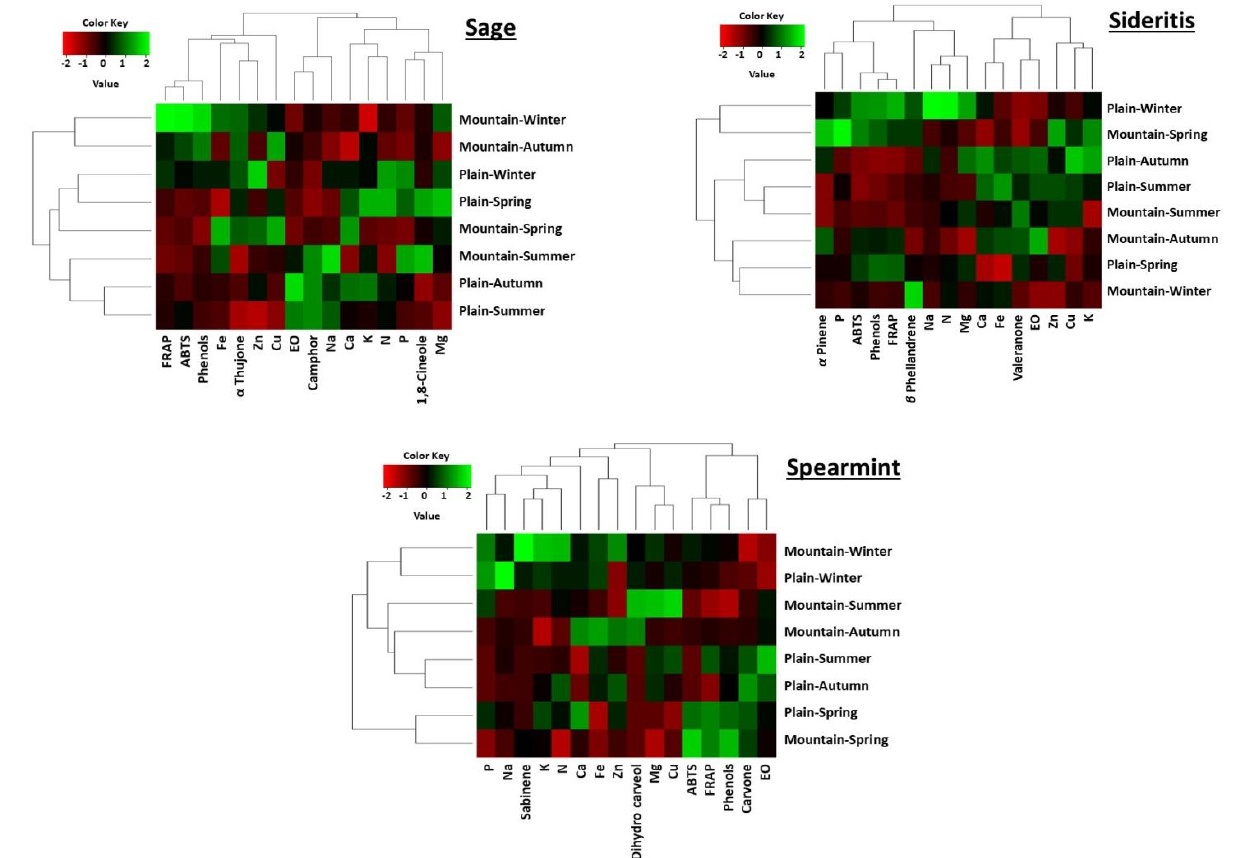
Figure 1. Relative changes (Heat maps) in total phenols (mg GAE g −1 Fw), antioxidant and reducing activity (FRAP, ABTS, mg trolox g −1 Fw), macronutrient (g kg −1 ) and micronutrient content (mg kg −1 ) content, and essential oil (EO) yield (%) and three major EO components in sage, sideritis and spearmint as affected by the altitude (mountain vs. plain) and season (summer, autumn, winter, spring). Red shades indicate the lower level (less than −2.0 fold), deep red corresponds to −1.0 fold, black signifies that the level is not different from the mean value, deep green corresponds to 1.0 fold, clear green indicates that the level is more than 2.0 fold higher than the mean value.